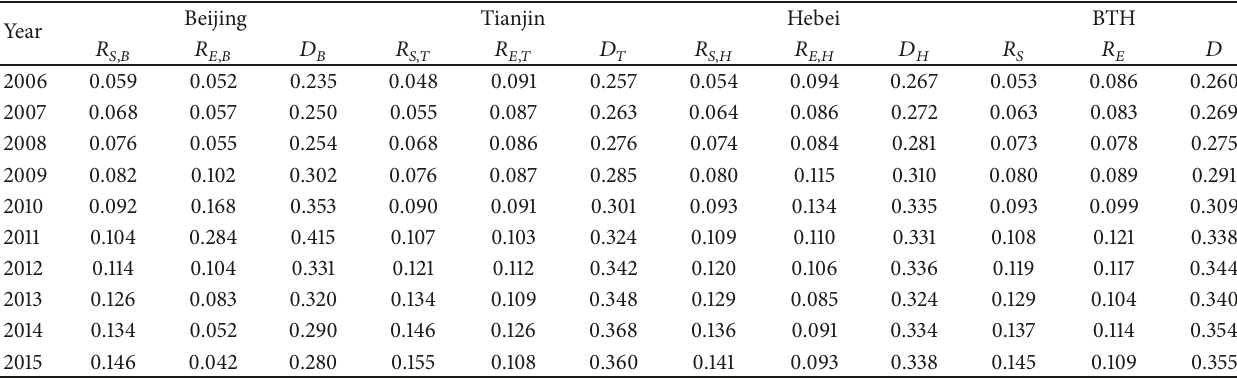
Table 4: Socio-economic development and environmental pollution scores and coupling coordination degree for each region in each year.